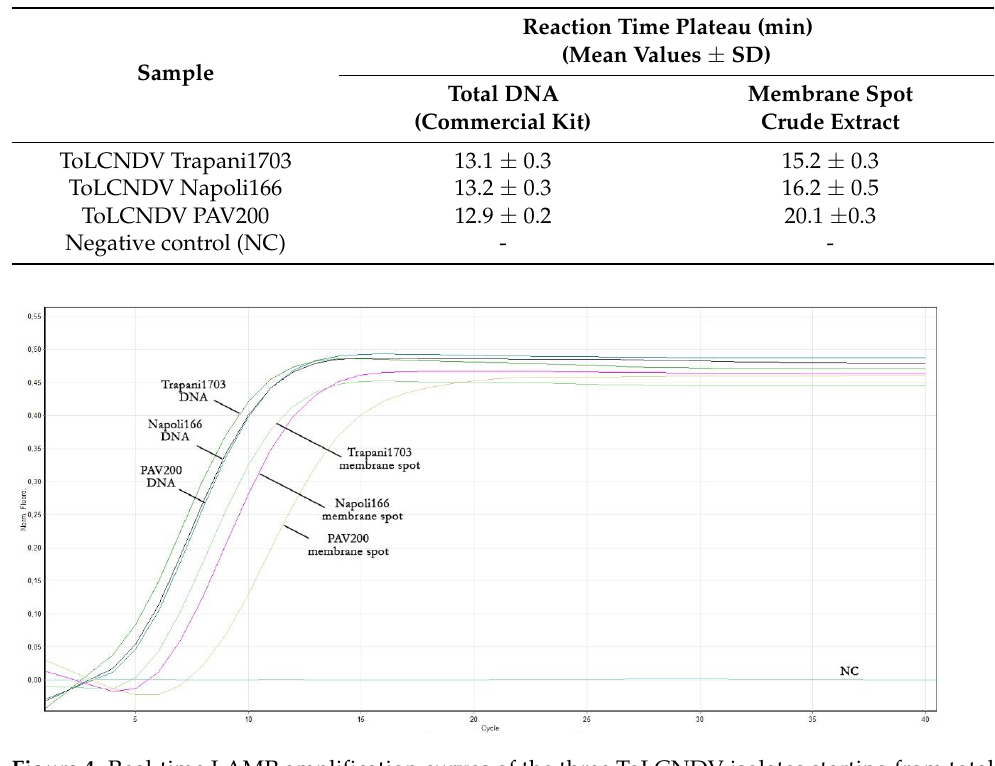
Table 5. Real-time LAMP assay performance comparison of different sample extraction methods for ToLCNDV detection.